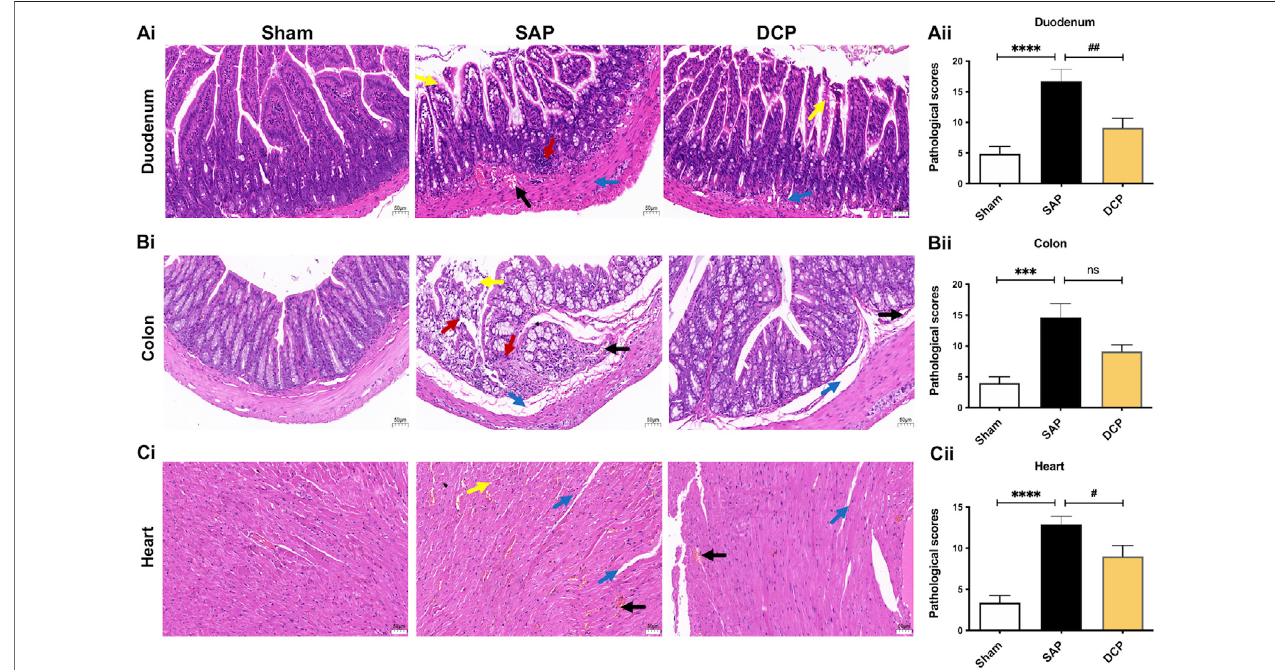
FIGURE3| DCPamelioratedthepathologicaldamageofintestinalandcardiactissuesinratswithSAP. (Ai,Aii) :RepresentativeimagesofH&Estaining(×200)on duodenum and corresponding pathological scores of rats in sham, SAP and DCP group; (Bi,Bii) : Representative images of H & E staining (× 200) on colon and corresponding pathological scores of each group; (Ci,Cii) : Representative images of H & E staining (× 200) on heart and corresponding pathological scores of each group. Arrows(blue,red,yellow,black) indicatededema,in fl ammation,necrosis,andhemorrhagerespectively.Theresultsarepresented asthemean±SEM.*** p < 0.005, **** p < 0.0001 vs. sham group, # p < 0.05, ## p < 0.01 vs. SAP group; ns, p > 0.05. sham: sham operation group; SAP: Sever acute pancreatitis group; DCP: Dao-Chi powder treatment